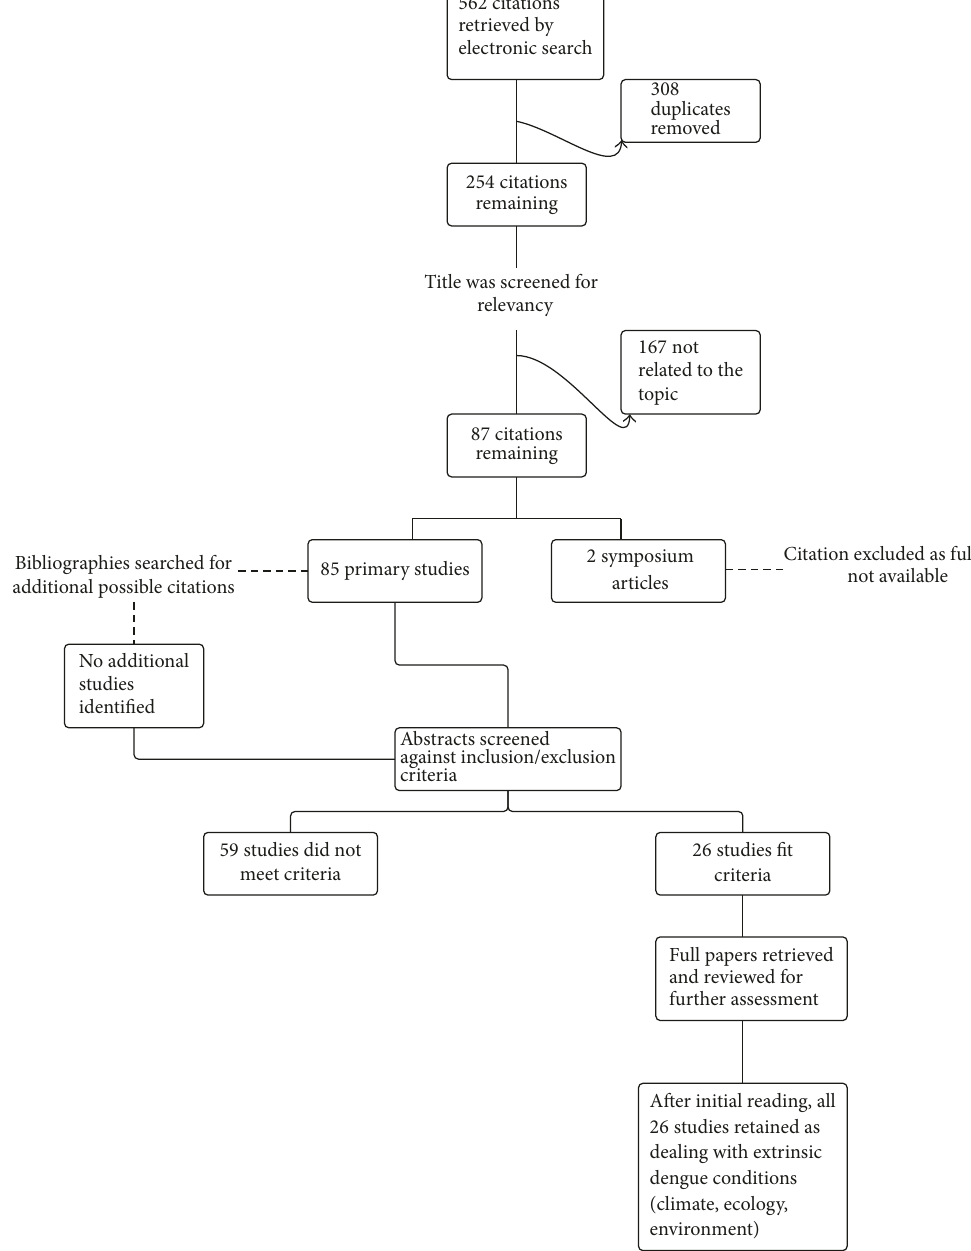
Figure 2: Literature selection and review